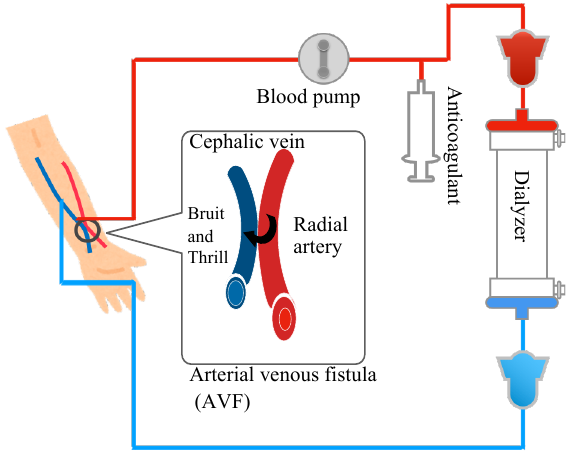
Figure 1. Overview of hemodialsis